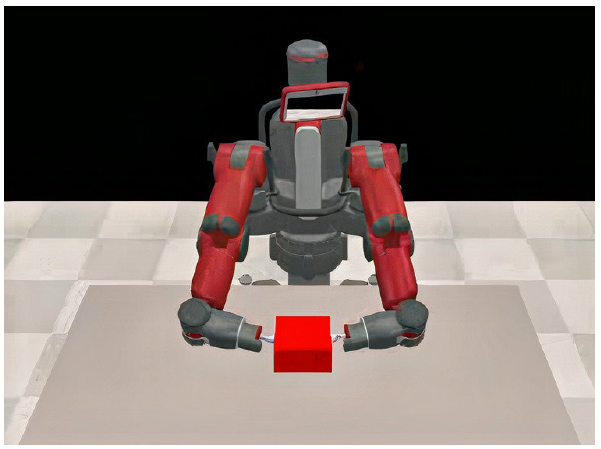
Figure 8. An illustration of dual-arm manipulation is shown using a Baxter robot where each arm might act as an RL